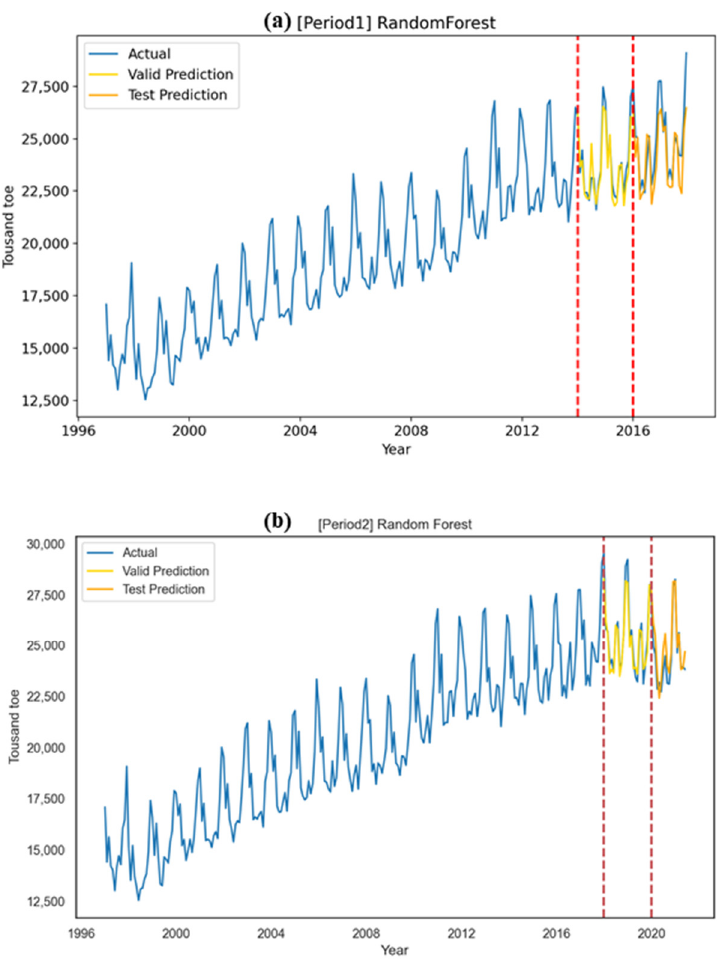
Figure 6. Random forest forecasting.